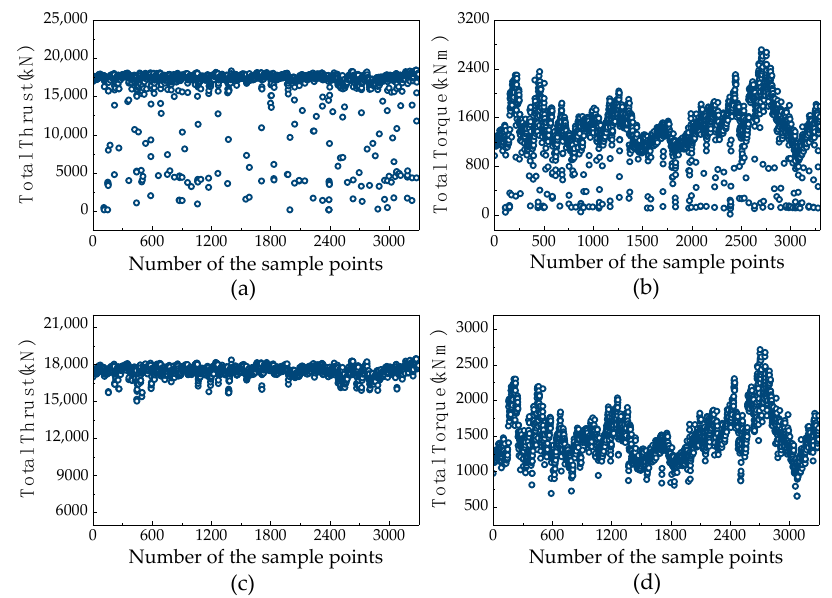
Figure 5. Data of tunneling loads in the Yin-Song Project: ( a ) total thrust before outlier processing, ( b ) total torque before outlier processing, ( c ) total thrust after outlier processing, ( d ) total torque after outlier processing.